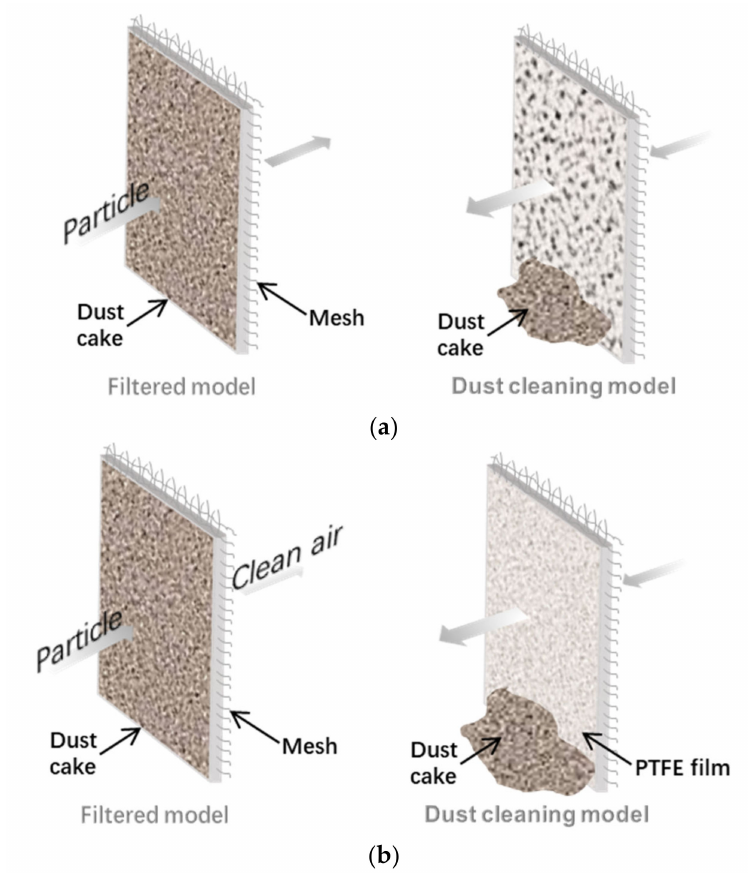
Figure 5. Dust cake detachment differences of the different evolutions of filter media. ( a ) Dust cake detachment for conventional fiber needled felt and ash layer (deep filtration). ( b ) Dust cake detachment for surface treatment and metal filter materials (apparent